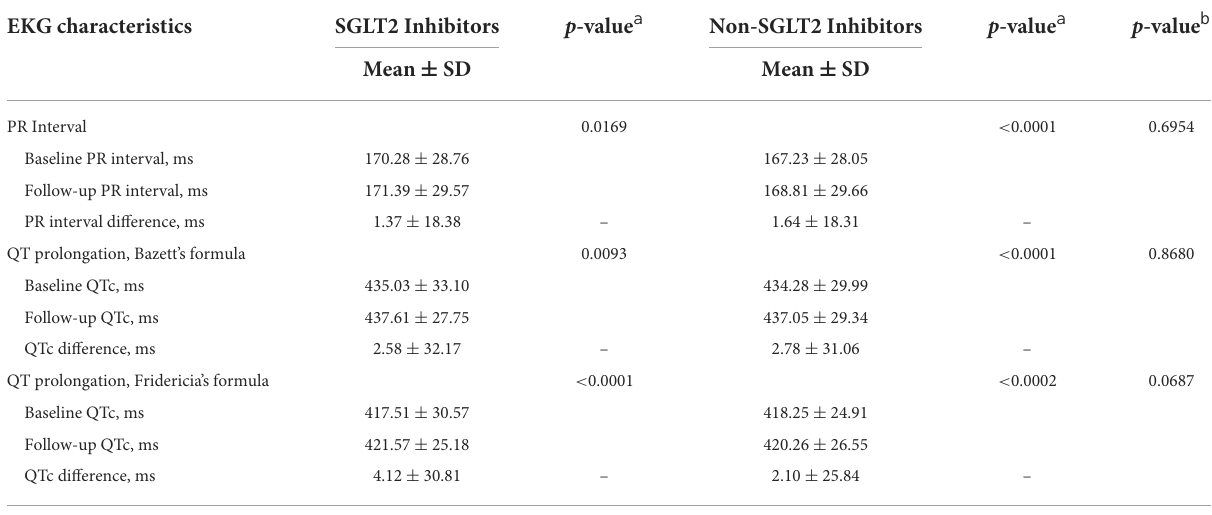
TABLE 2 ECG characteristics of study population.